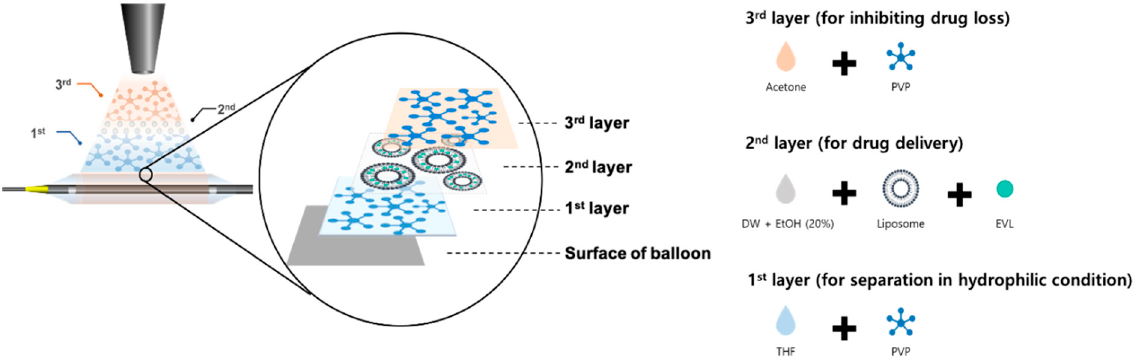
Figure 1. Schematic illustrations for a multilayer functionalized drug-eluting balloon (DEB) system.